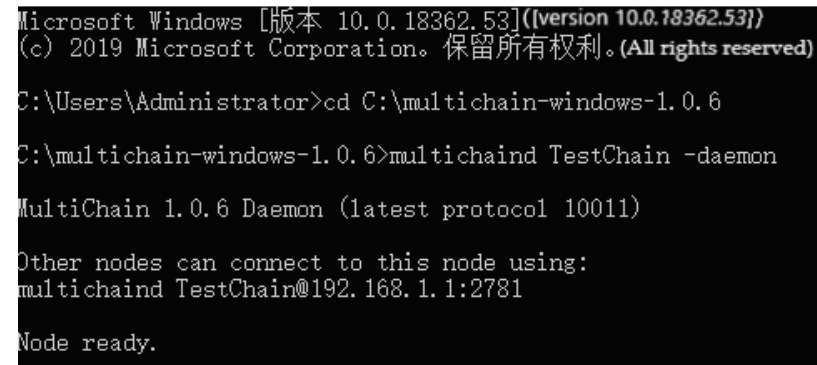
Figure A1. The establishment of multichain nodes.